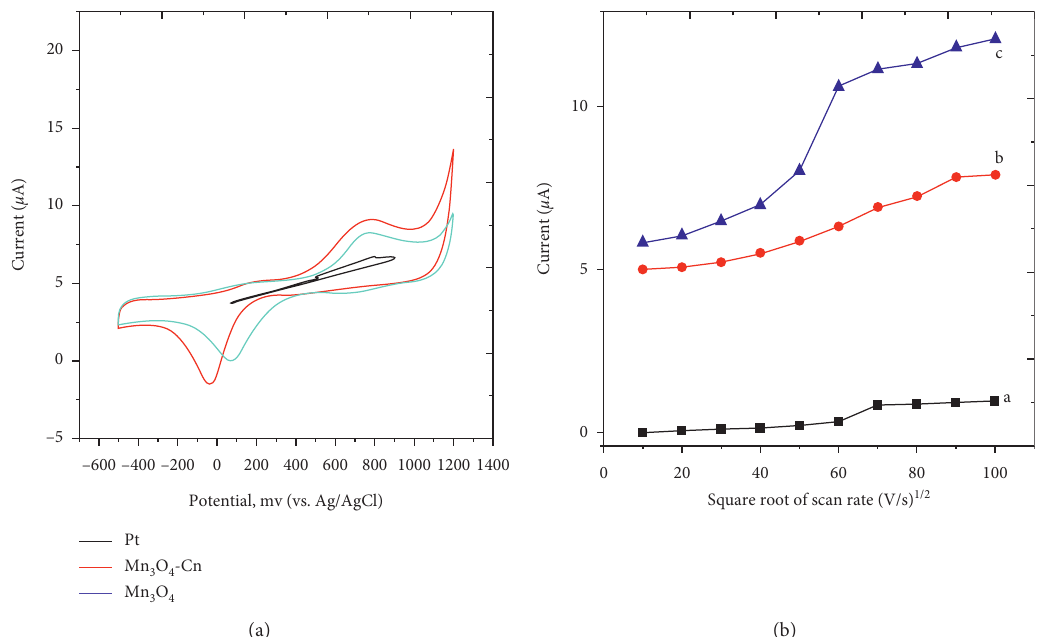
Figure 3: (a) Cyclic voltammetry plot of Pt/Mn 3 O 4 and Pt/Mn 3 O 4 -Cn electrodes in 0.1M PBS and 5 mM Fe (CN) 6 with scan rate s. (b) Randle-Sevcik’s plot of anodic peak current versus square root of scan rate 5 to 100mV/s for (a) bare Pt, (b) Pt/Mn 3 O 4 , and (c) Pt/